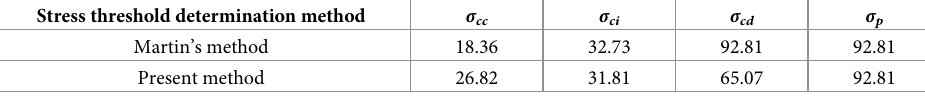
Table 3. Stress thresholds determined with different methods.